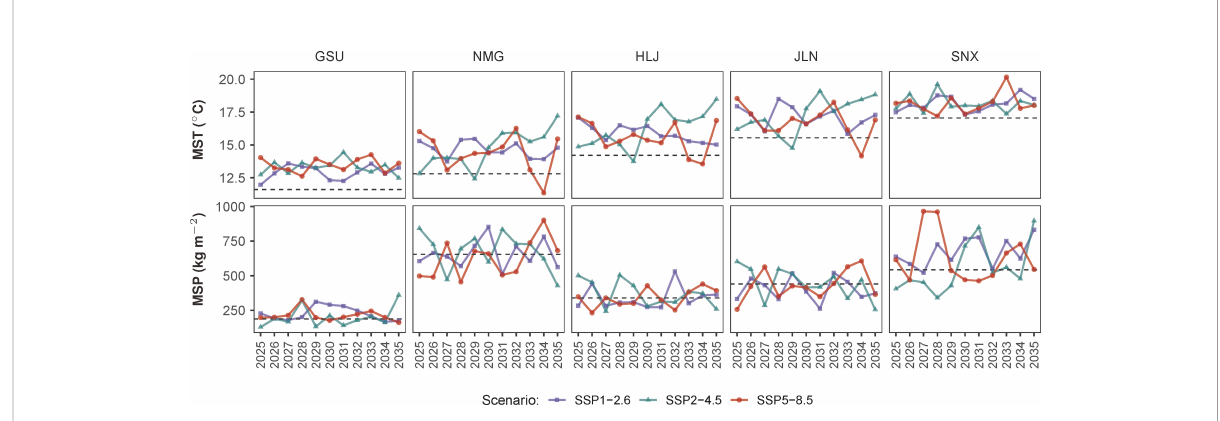
FIGURE 2 Climatic variations during the alfalfa growing seasons from 2025 to 2035 in six northern provinces in China based on the BCC-CSM2 global circulation model simulations driven by the SSP1-2.6, SSP2-4.5, and SSP5-8.5 scenarios. MST, mean seasonal temperature; MSP, mean seasonal precipitation. The dashed horizontal lines represent the province-speci fi c 20 th -century mean.